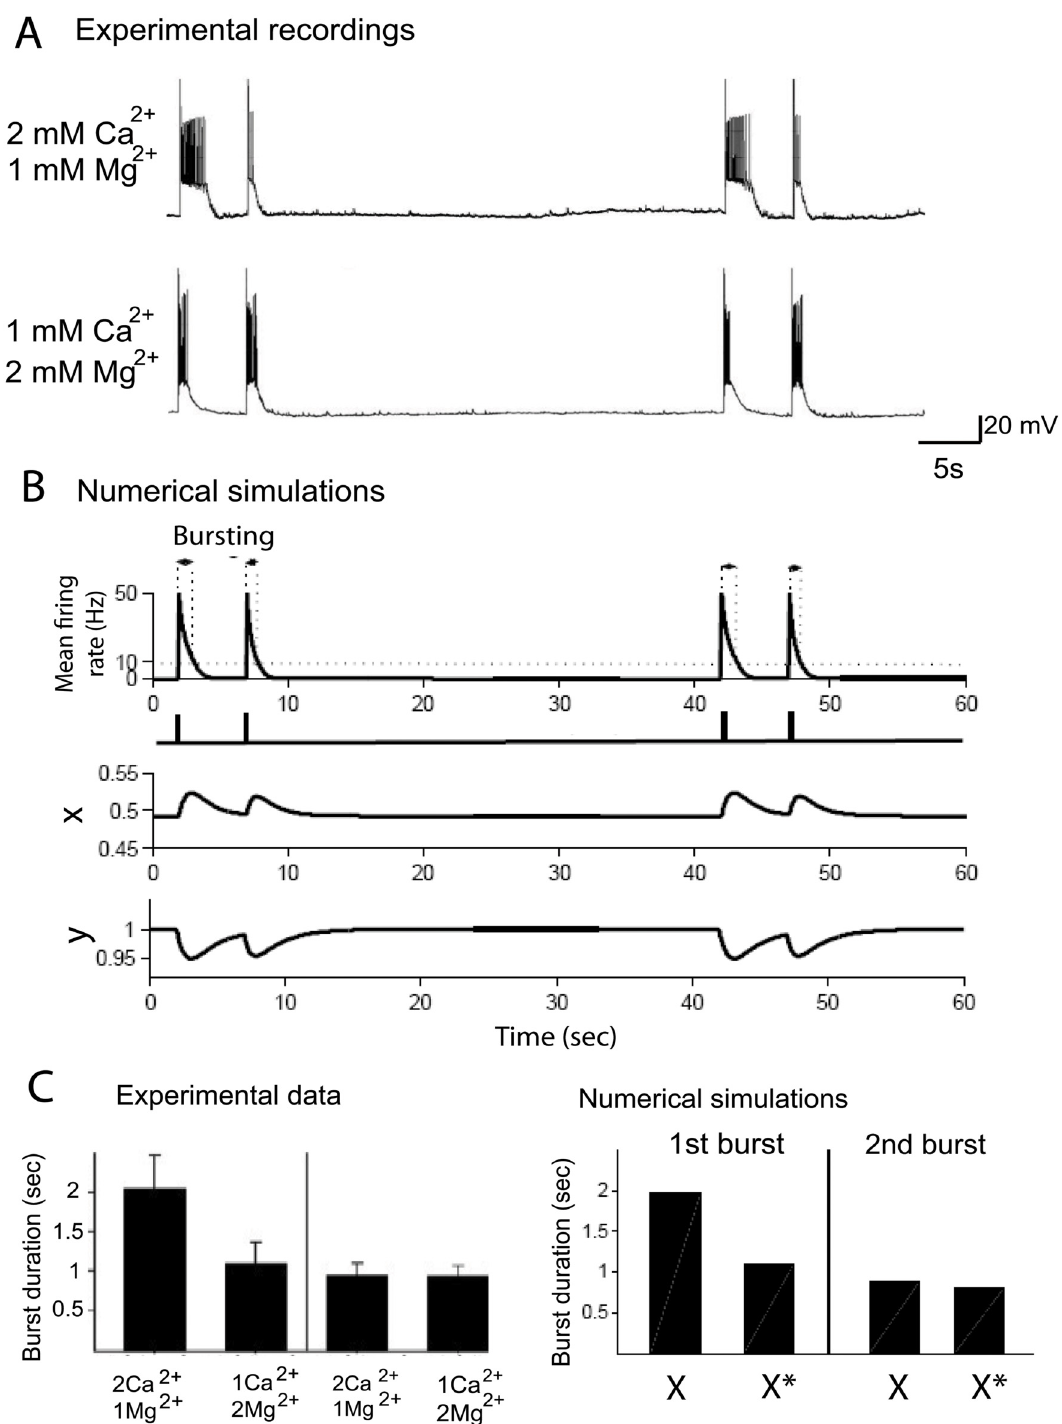
Fig 4. Calcium-dependence of reverberation bursts in small networks. (A) Evoked bursts recorded after exchanging the medium from 2 mM CaCl 2 and 1 mM MgCl 2 to 1 mM CaCl 2 and 2 mM MgCl 2 . (B) Simulated response to evoked bursts: the extracellular concentration change is modeled by adjusting the parameter X to approximate the burst duration variation within the calcium concentration decrease. (C) Comparison of the burst durations demonstrating a reduction in the duration of the 1st burst (35 seconds interval burst) but not the 2nd burst (5 seconds interval burst), when [ Ca 2+ ] was reduced and [ Mg 2+ ] increased. We compare the first and second burst durations of the model for value of X = 0.50 given in Table 1 and X * = 0.4925, which account for the burst durations variations due to calcium concentration changes observed in left.